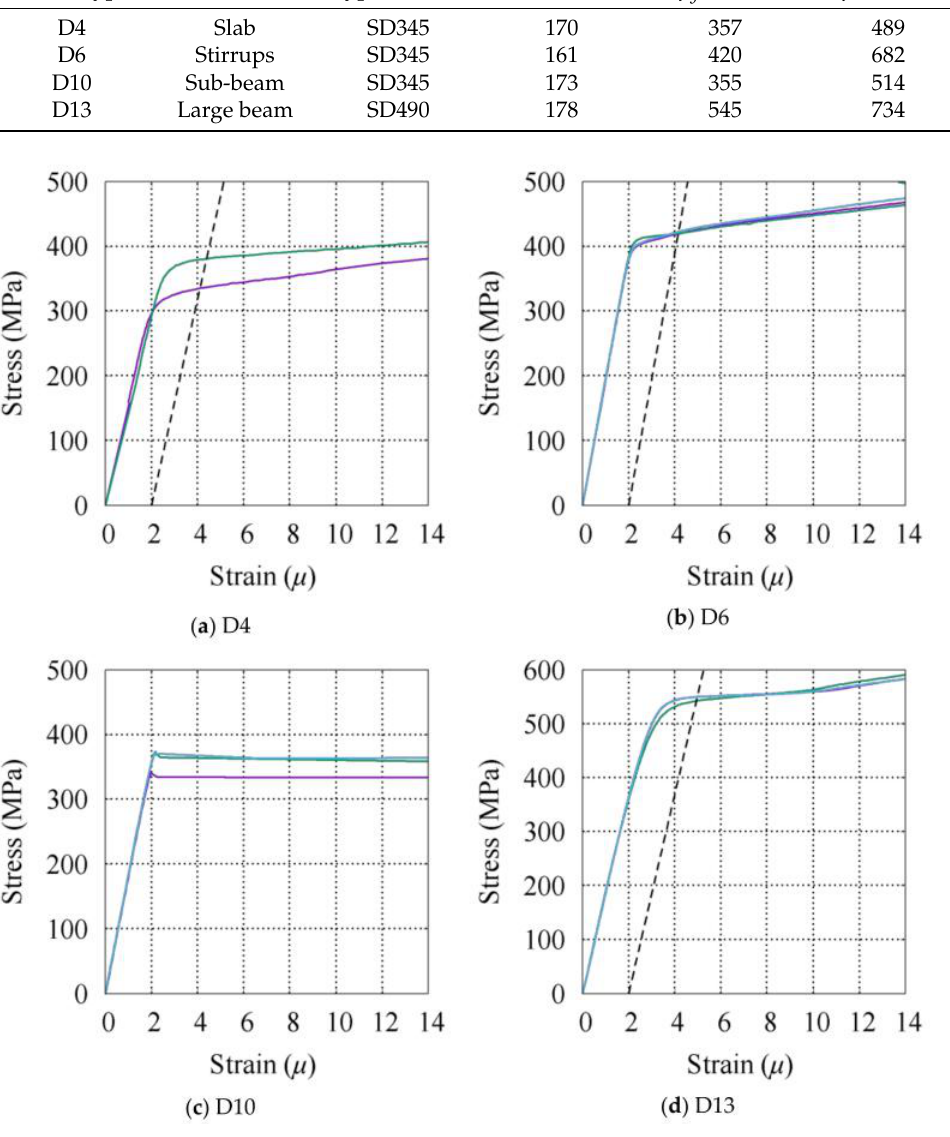
Figure 3. Rebar tension test results. ( a ) D4, ( b ) D6, ( c ) D10, ( d )